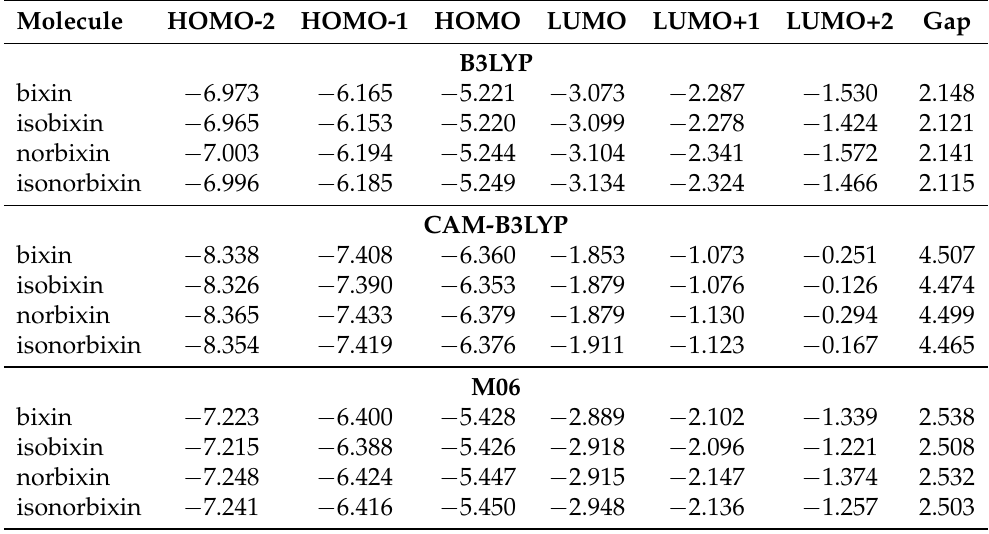
Table A12. Frontier MOs and gap energy values for the dyes in chloroform solution. These results were obtained by employing the 6-31+G(d,p) basis set. All values are in electron-Volt